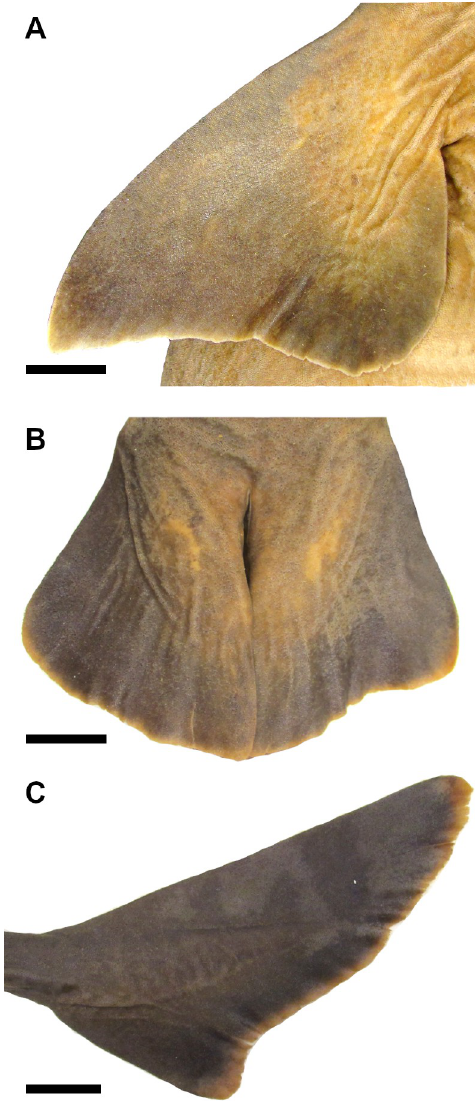
Fig 30. Pectoral (A), pelvic (B) and caudal (C) fins of C . australis (NMNZ P 28732, adult female, 1189 mm TL) in ventral (A,B) and lateral (C) views. Scale bars: 20